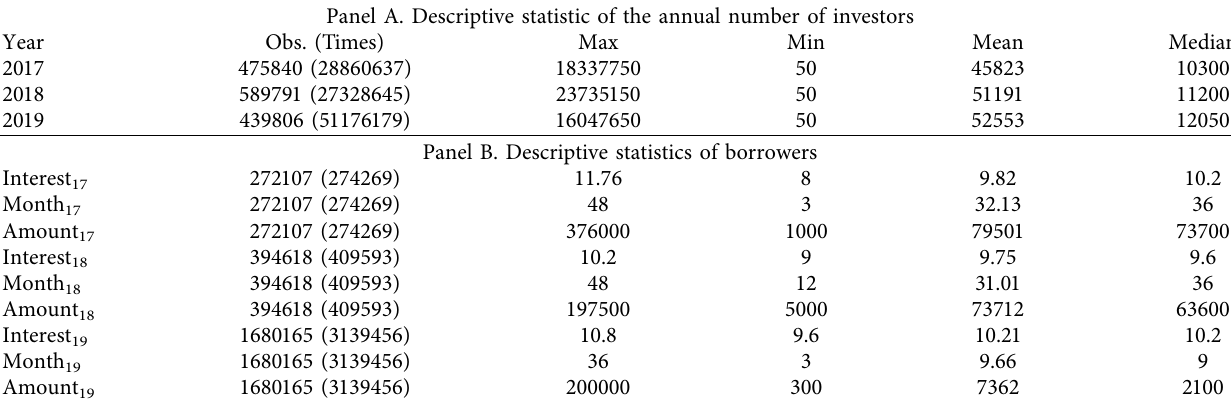
Figure 1: The growth of transaction amount and number of transactions. Table 5: Descriptive statistics of participation number.